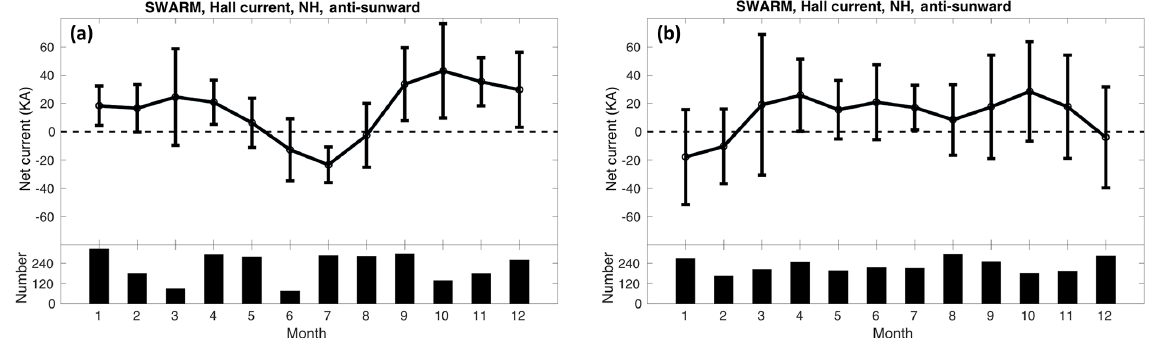
Figure 7. Annual variation of net currents flowing from the day to night side. In the two hemispheres opposite annual variations are observed. The error bar indicates the uncertainty of the values. In the bottom panels the number of contributing orbits are